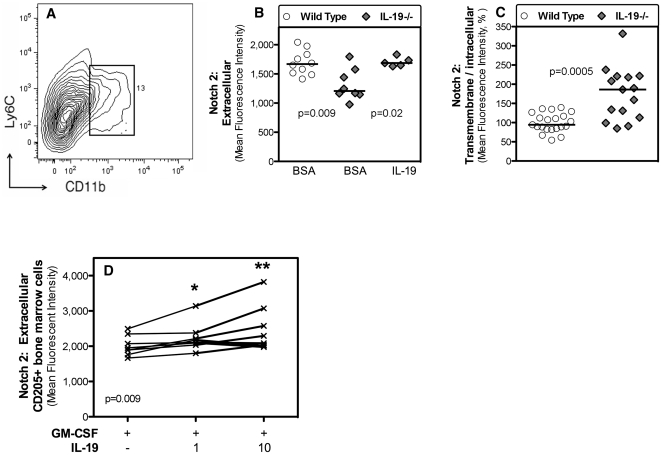
IL-19 regulates Notch2 expression in lung monocytes and bone marrow derived dendritic cells.(A) The density plot of lung cells shows the electronic gate used to identify CD11bint/Ly6Cint lung monocytes. Extracellular (B) or transmembrane/intracellular (C) Notch2 expression (mean fluorescence intensity) by lung CD11bint/Ly6Cint monocytes is shown from groups of individual wild type (circles) and IL-19-/- (gray diamonds) mice. The data were pooled from two independent experiments. Horizontal lines indicate medians. (B) The mice were given intranasally control protein (bovine serum albumin, BSA) solution or IL-19 (Figure S1). (C) Naïve mice were analyzed. The two experiments had different baseline mean fluorescence intensity for Notch2 expression. Therefore, mean fluorescence intensities were plotted relative to the respective median value of wild type mice for each of the experiments and then the data were pooled. (D) Extracellular Notch2 expression by bone marrow derived CD205+ dendritic cells. Bone marrow cells were isolated from 8 individual IL-19-/- mice and cultured in the presence of granulocyte-macrophage colony stimulating factor (GM-CSF), with or without the addition of IL-19 at 1 or 10 ng/ml as indicated. CD205+ cells were electronically gated and Notch2 expression was determined by flow cytometry. The lines connect the data from each individual mouse. The data were pooled from two independent experiments. Statistical analysis was with the Friedman test for non-parametric repeated measures (overall p = 0.0009) and Wilcoxon matched-pairs signed rank test (* p<0.01).